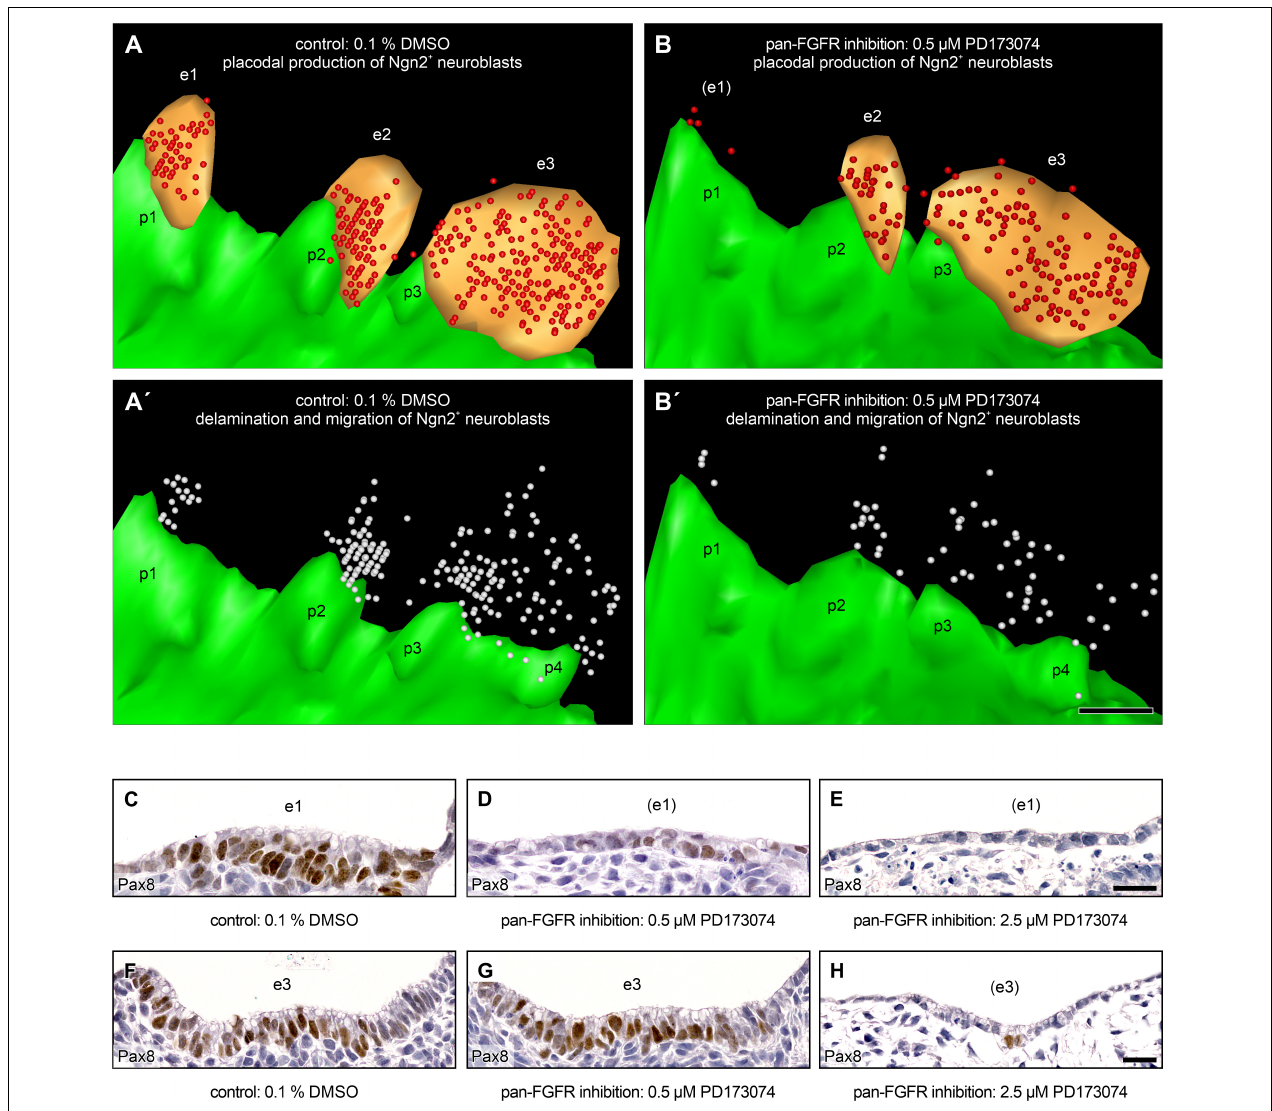
FIGURE 7 | Production and delamination of epibranchial Ngn2 + neuroblasts in 9–14 somite mouse embryos, cultured for 24 h. 3D reconstructions show that, compared to DMSO control embryos (A) , the number of Ngn2 + neuroblasts (red spheres) in the epibranchial placodes 1, 2, and 3 (e1, e2, e3; orange) decreases to varying degrees (e1 > > e2 > e3) after exposure to 0.5 µ M of the pan-FGFR inhibitor PD173074 ( B , also note loss of ectodermal thickening in the position of e1; for details, see Figure 4 and Table 2 ). (A’,B’) Largely proportionally to the number of Ngn2 + intraplacodal neuroblasts, the number of Ngn2 + delaminating neuroblasts respectively of those that have already been deposited within the mesenchyme adjacent to the epibranchial placodes (both populations shown jointly as white spheres) also decreases. (C–H) Furthermore, treatment with PD173074 reduces, again roughly proportionally to the number of Ngn2 + intraplacodal neuroblasts, the number of Pax8 + intraplacodal (precursor) cells in a dose-dependent manner. p1, p2, p3, and p4, pharyngeal pouches 1, 2, 3, and 4 (green). Scale bars: 100 µ m (A–B’) , 20 µ m (C–E,F–H)